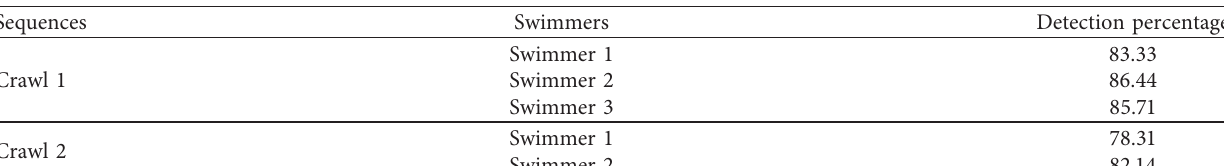
Table 3: Evaluation of the Scaled Composite JTC for the initialization of the reference. Crawl-Swimming Championships in Limoges, France, April 2015.